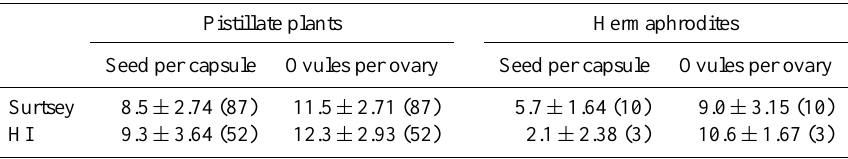
Table 2. Number of ovules and seeds per capsule in Honckenya peploides on Surtsey and Heimaey + mainland Iceland (HI) ( ± SD). Number of individuals is included in parentheses.